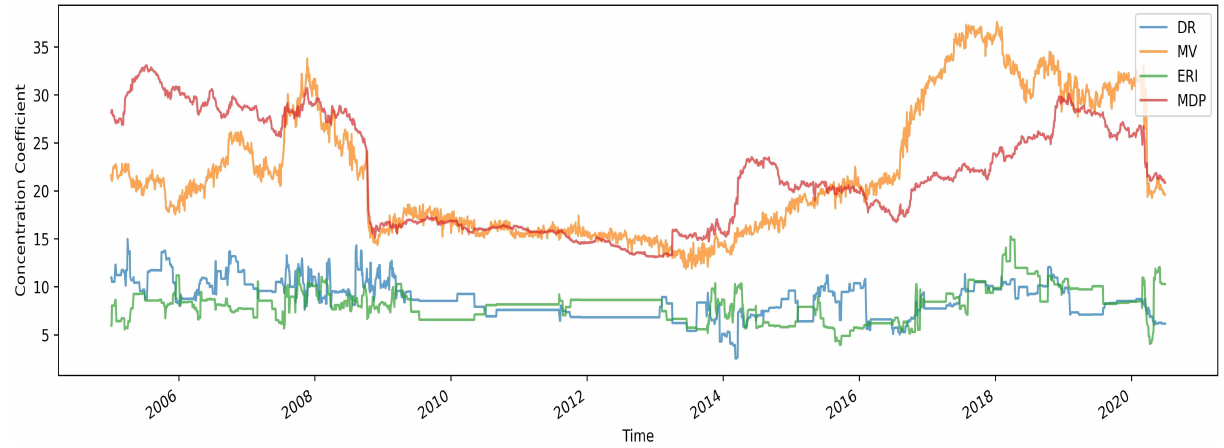
Figure 4. CC of DR, MV, MDP, and ERI for the 361-stock portfolio over the backtest period.